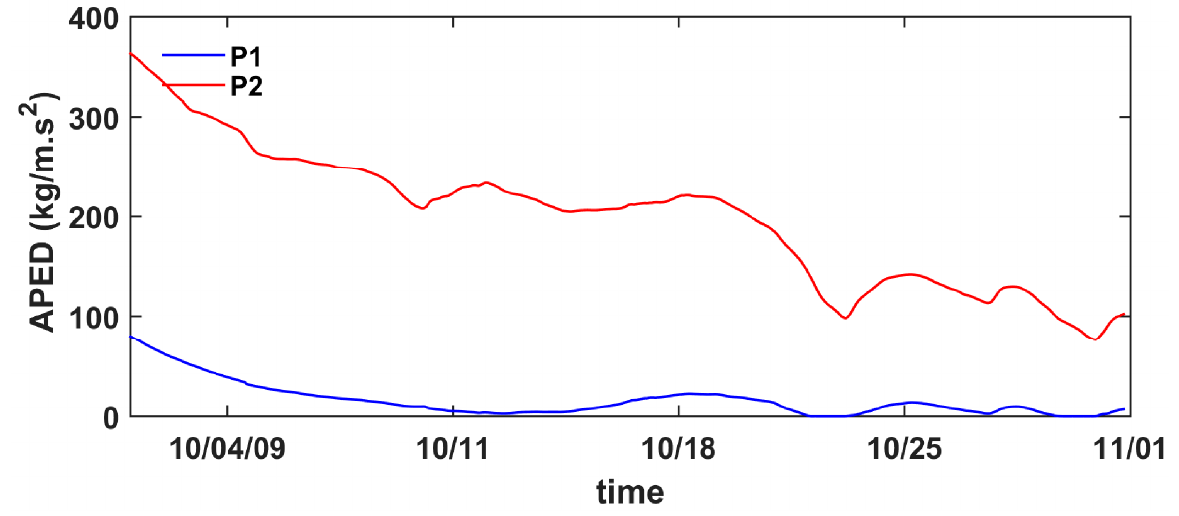
Figure 14. Time variations of calculated APED at locations P1 and P2.